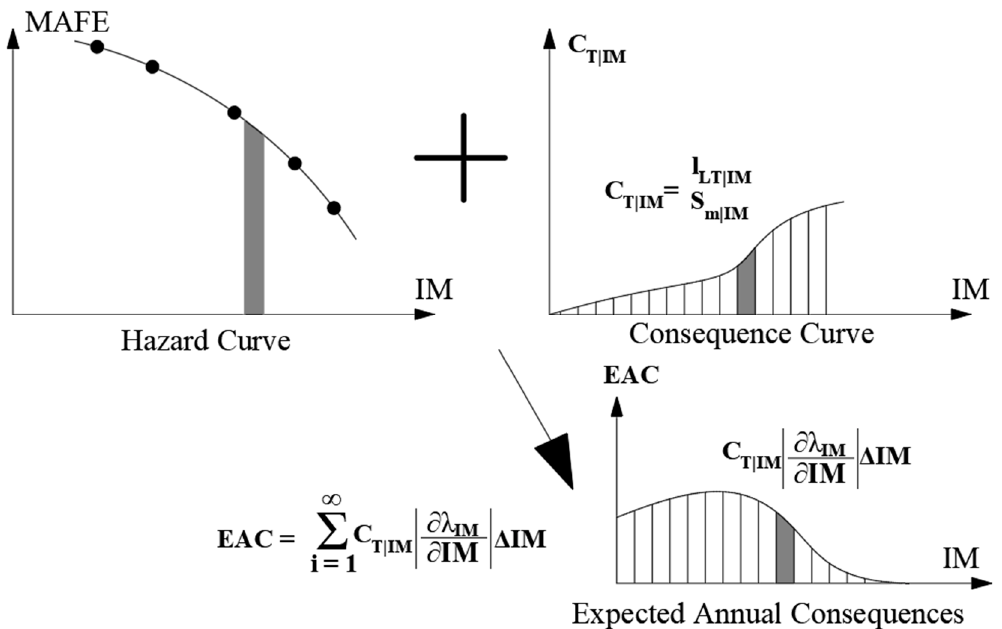
Figure 7. Illustration for computing EAC using a hazard curve and consequence curve, adapted from [49].